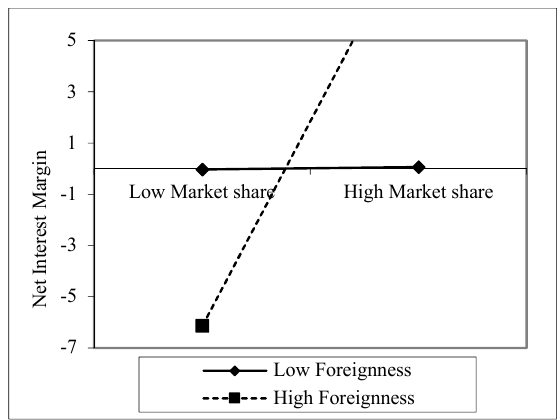
Figure 4. Market Share × Foreignness.